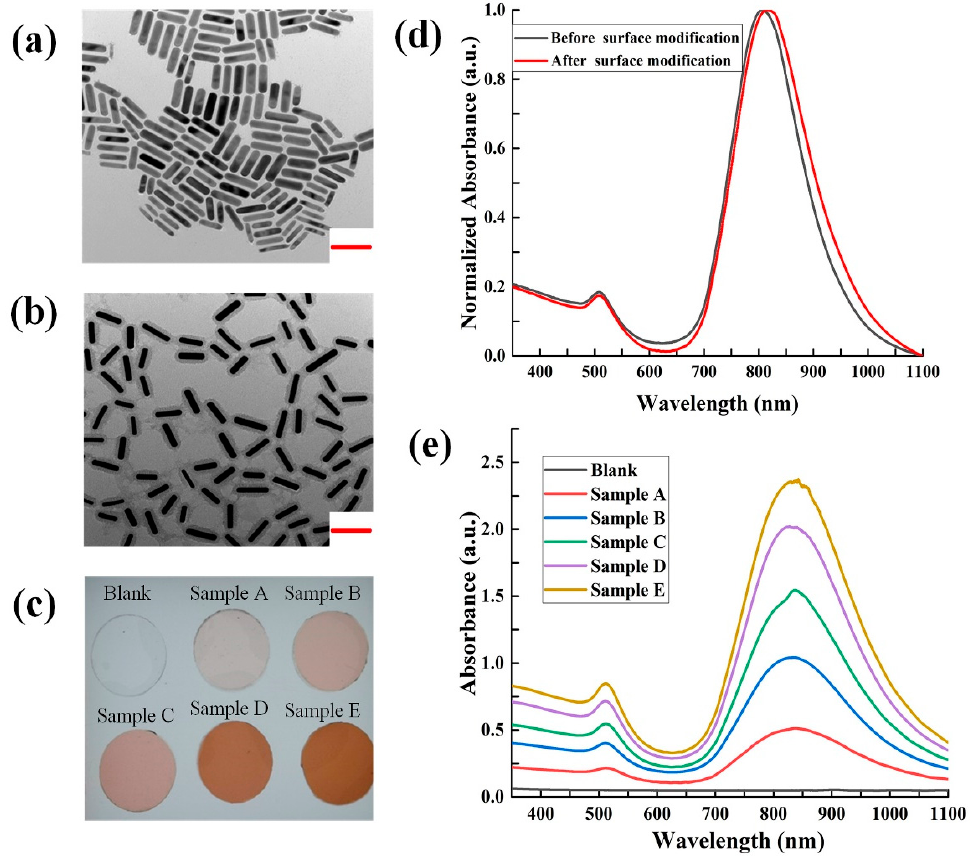
Figure 4. Characterization of the AuNPs and AuNPs-PDMS films. ( a ) TEM images of the AuNPs. ( b ) TEM images of the silica coated AuNPs. ( c ) Images of the AuNPs-doped and blank PDMS films. ( d ) UV-Visible absorption spectra of the AuNPs. ( e ) UV-Visible absorption spectra of the AuNPs-PDMS films. The scale bar is 100 nm. AuNPs concentrations in sample films A~E are 0.031%~0.155%.